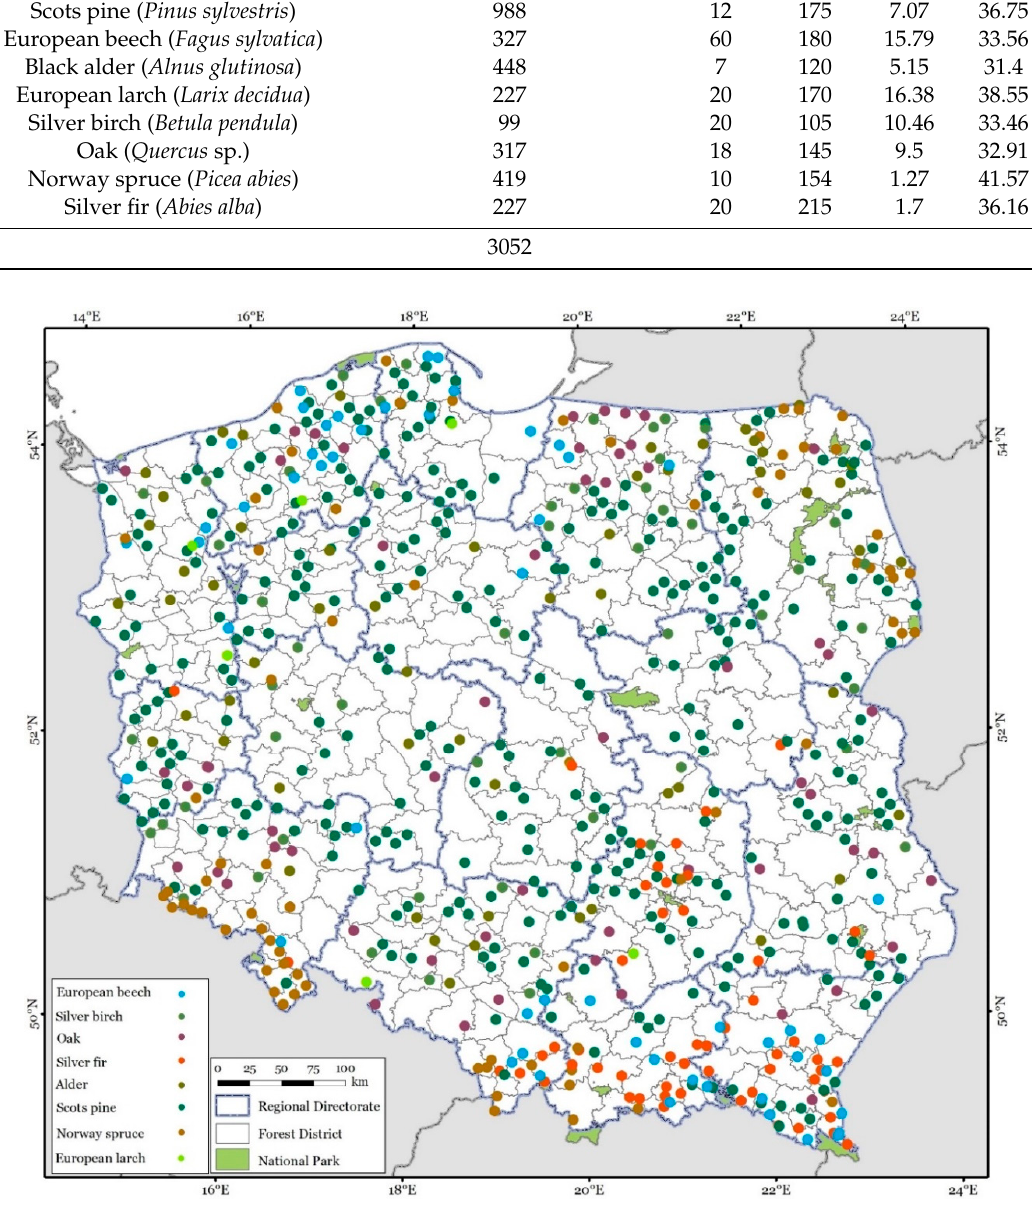
Figure 1. The location of sample plots for the analyses of the forest-forming tree species in Poland. From these plots, stem analysis data used for model development were collected. From these plots, stem analysis data used for model development were